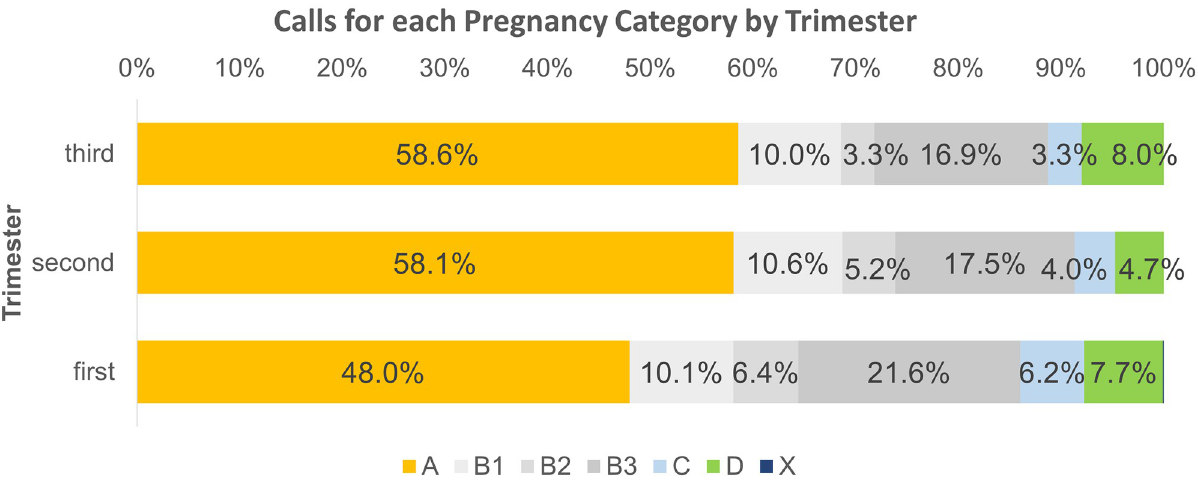
PLOS ONE | https://doi.org/10.1371/journal.pone.0270940 October 6,